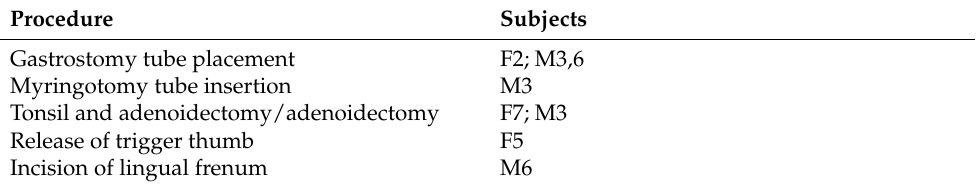
Table 4. Procedures performed are listed and the patients receiving them are